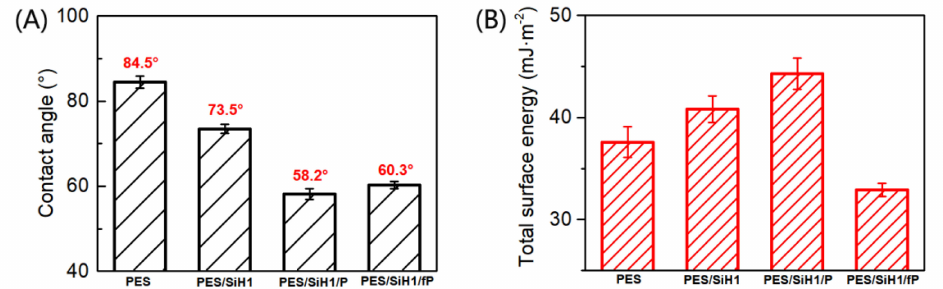
Figure 7. ( A ) The water contact angles of the PES, PES/SiH1, PES/SiH1/P, and PES/SiH1/fP membranes; ( B ) the total surface energy of the PES, PES/SiH1, PES/SiH1/P, and PES/SiH1/fP membrane surfaces calculated by the two-liquid geometric